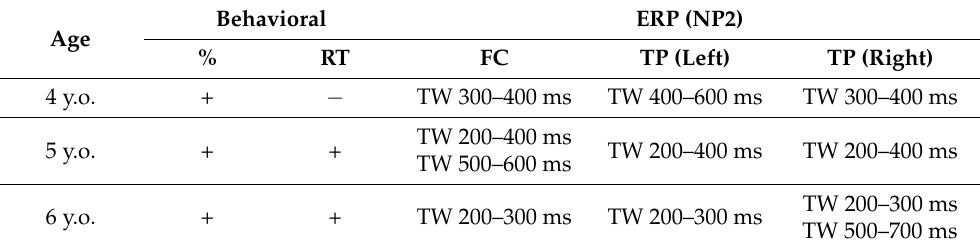
Table 2. Behavioral and ERP significant differences were obtained for the third word (NP2) of AV vs. PV sentences processing in age